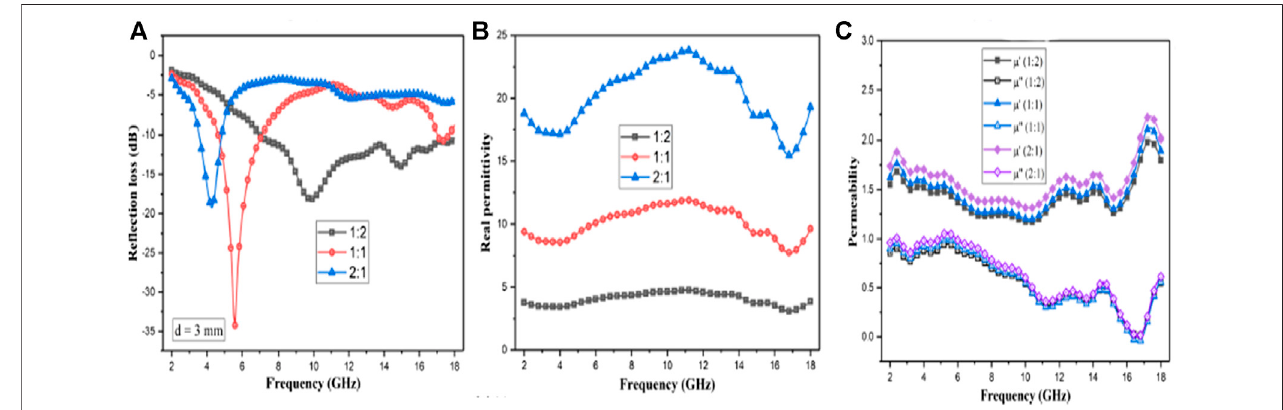
FIGURE 10 | (A) Re fl ection loss. (B) Real permittivity. (C) Real and imaginary permeability illustrations of NiO&TiO 2 @C composites (Feng et al., 2019).